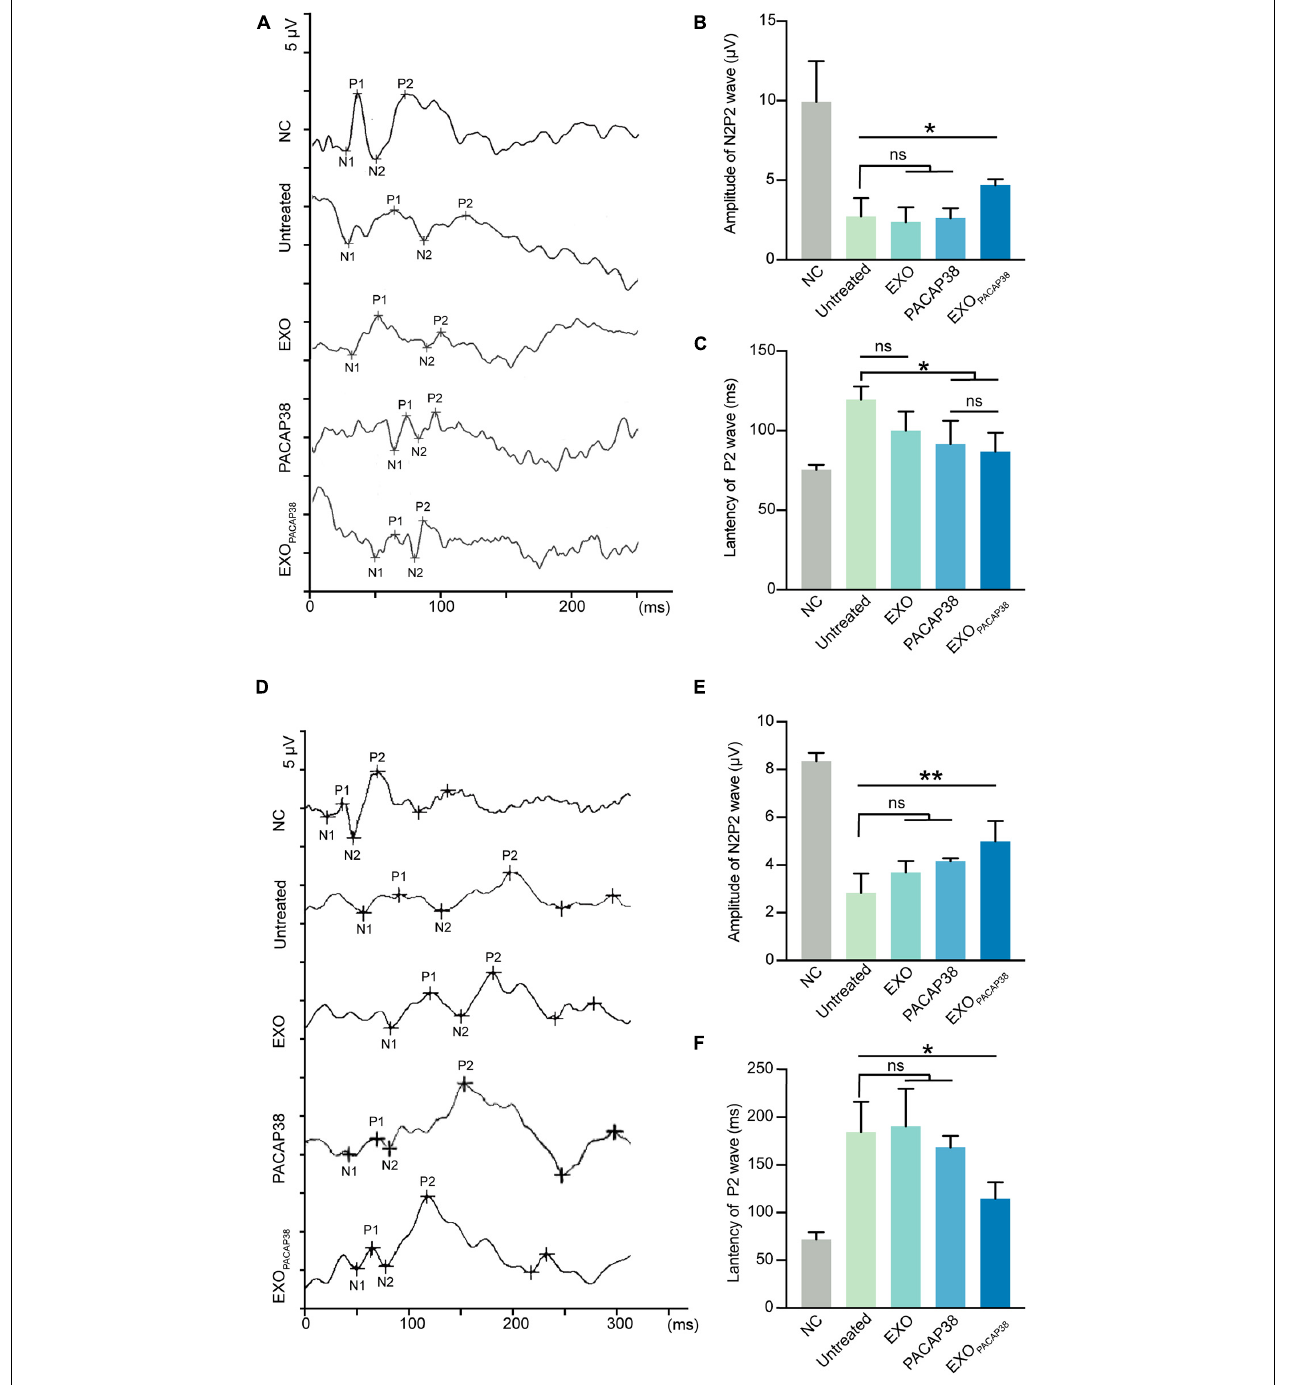
FIGURE 4 | Evaluation of visual function in EXO PACAP 38 -treated rats after ONC. (A) F-VEP was recorded at 7 days after injury in normal controls; untreated group; and EXO-, PACAP38-, and EXO PACAP 38 -treated groups. (B) Analysis of N2P2 wave at 7 days after injury ( n = 4; values are mean ± SEM, one-way ANOVA, * P < 0.05). (C) Analysis of P2-wave latencies at 7 days after injury. No statistical significance in P2-wave amplitudes was observed at 7 days after injury in the EXO PACAP 38 -treated group compared with the untreated group ( n = 4; values are mean ± SEM, one-way ANOVA, * P < 0.05). (D) F-VEP was recorded at 14 days after injury in normal controls; untreated group; and EXO-, PACAP38-, and EXO PACAP 38 -treated groups. (E) Analysis of N2P2 wave at 14 days after injury ( n = 4; values are mean ± SEM, one-way ANOVA, ** P < 0.01). (F) Analysis of P2-wave latencies at 14 days after injury. Significant improvement in P2-wave latencies was achieved at 14 days after injury in the EXO PACAP 38 -treated group compared with the untreated group ( n = 4; values are mean ± SEM, one-way ANOVA, * P < 0.05).